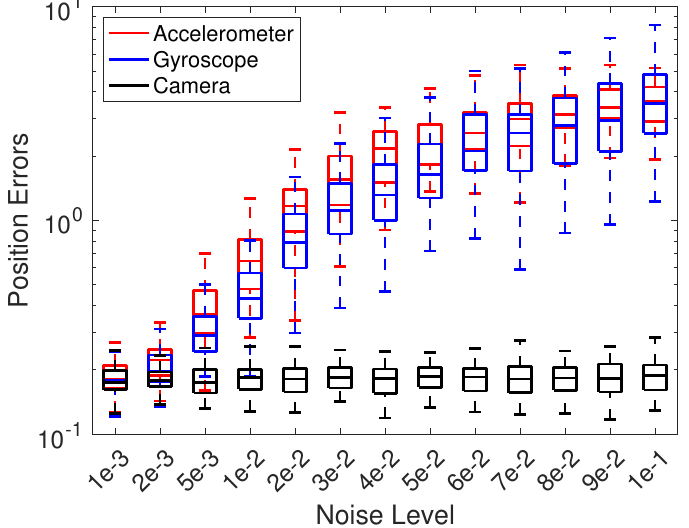
Figure 9. Error of EKF estimation under different noise level on accelerometer, gyroscope, and camera measurement.